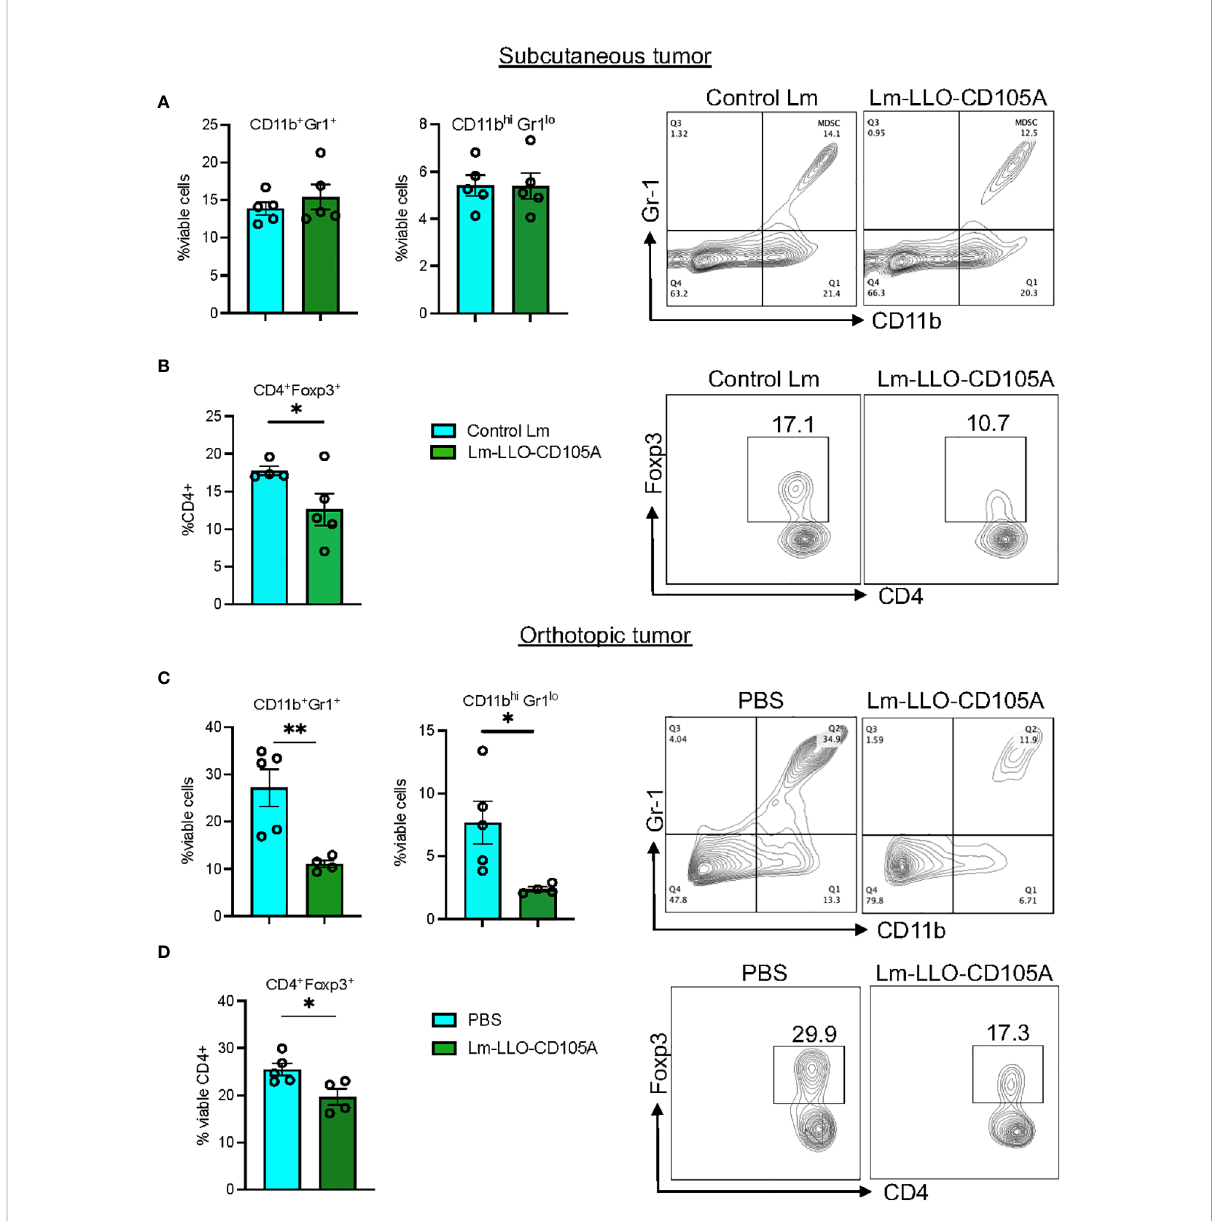
FIGURE 5 Lm-LLO-CD105 remodels the tumor microenvironment to reduce MDSC and Treg-mediated immunosuppression. (A) MDSC population between Control Lm and Lm-LLO-CD105A vaccinated group. (B) Statistical representation and dot plot of Treg population in the Lm-LLO- CD105A and control groups. (C) MDSC population in the Lm-LLO-CD105A vaccinated group in comparison to the PBS group. (D) Flow plot and statistical representation of Treg population in the Lm-LLO-CD105A vaccinated and control groups. Data were analyzed using unpaired t-test. *P < 0.05, **P < 0.01. All error bars are shown as mean ±